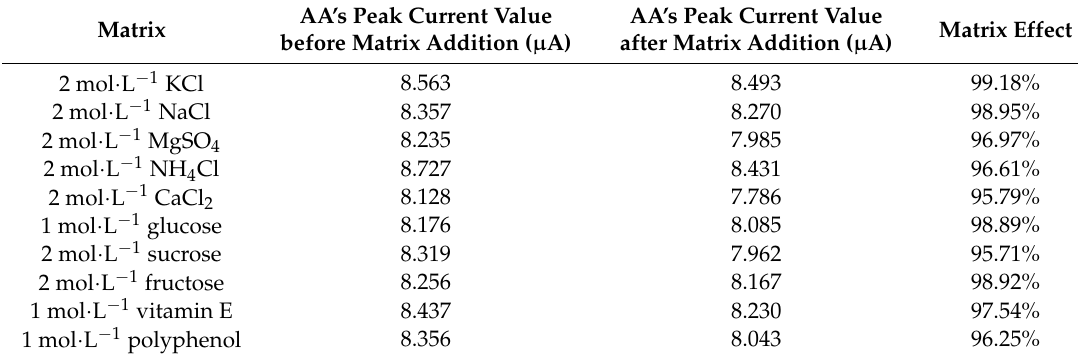
Table 2. Matrix effect studies for 1.0 × 10 − 2 mol/LAA.